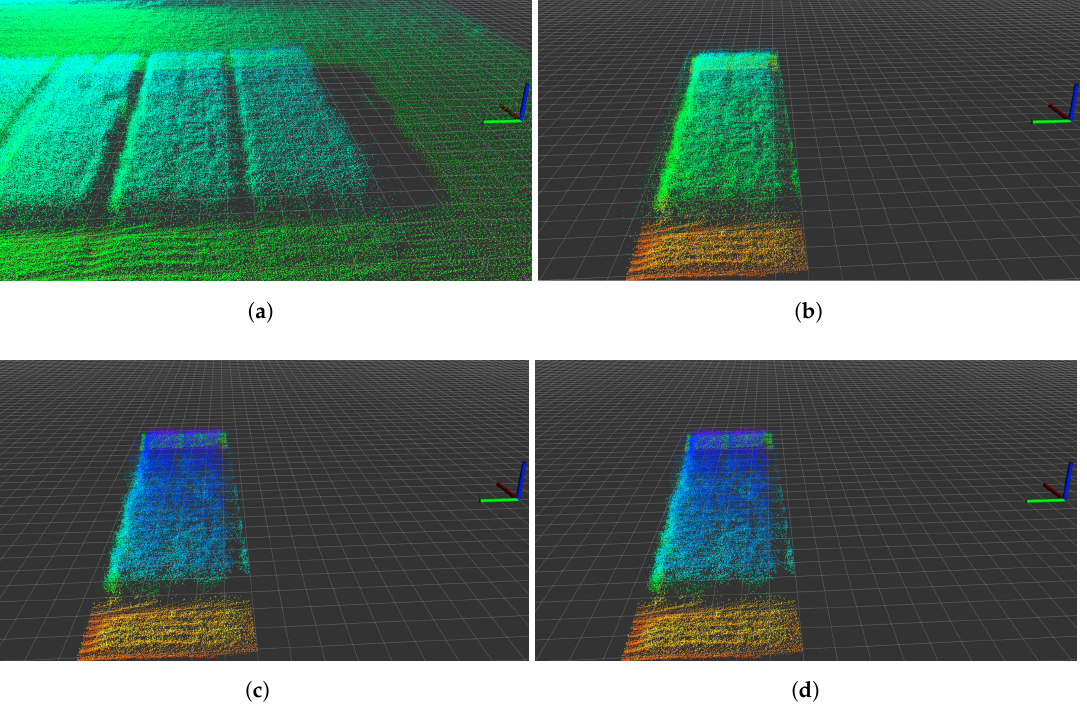
Figure 5. Processing steps for individual gross parcels. The ROS rviz 3D visualisation tool grid plane in the background is divided into 0.5 × 0.5 m grids. ( a ) raw mapped point-cloud; ( b ) point-in-polygon extraction; ( c ) statistical outlier removal; ( d )